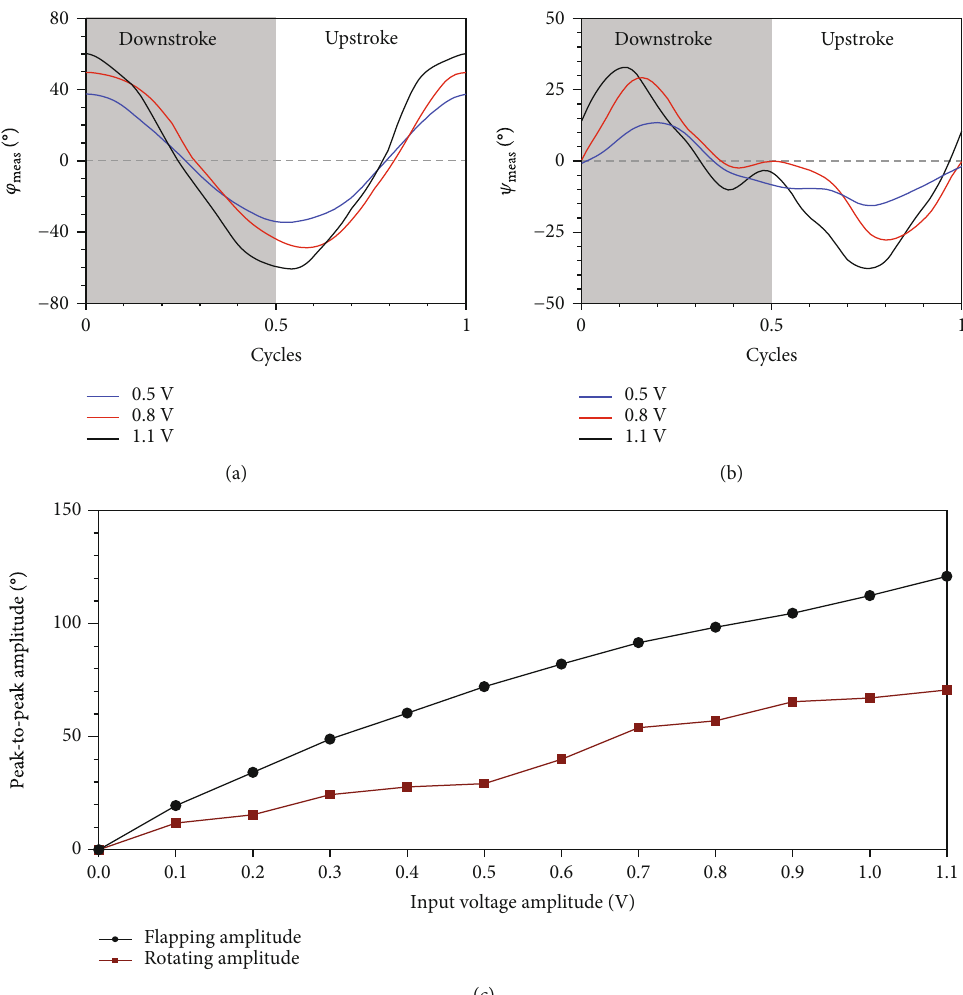
Figure 7: The measured 2-DOF wing kinematics of (a) fl apping and (b) rotating. For simplicity, measured results under only three input voltages are plotted, and each curve is obtained from the measured points by sixth-order Fourier fi tting. Figure (c) shows the relationship between the peak-to-peak amplitude of the measured wing kinematics and the input voltage